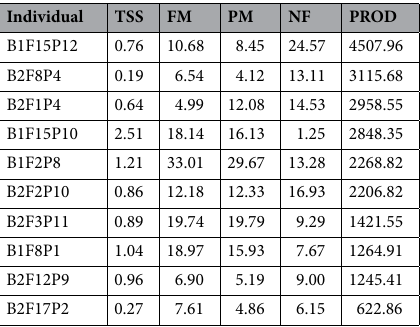
Table 4. List of selected individuals who presented positive genetic values in the traits soluble solids content (TSS), fruit mass (FM), pulp mass (PM), number of fruits per plant (NF), and production per plant (PROD). The individuals were classified in descending order considering the